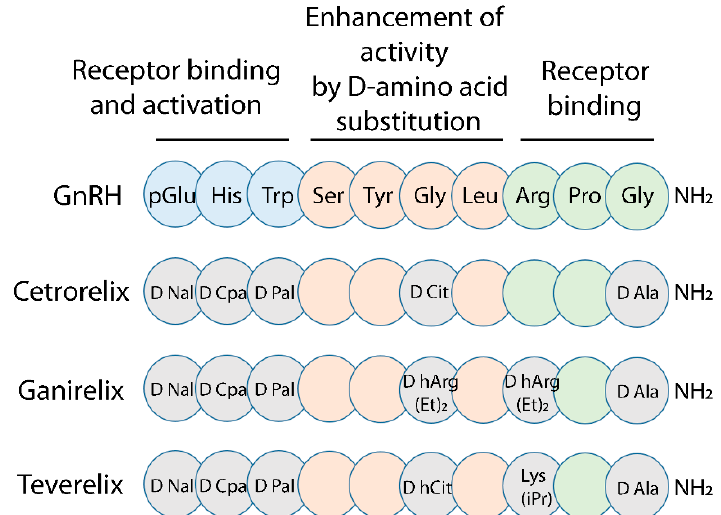
Figure 1. Amino acid sequence of mammalian gonadotropin releasing hormone (GnRH) and antagonists. Substitution of amino acids at position 6 (orange) by D-amino acids increases binding affinity and decreases metabolic clearance, resulting in increased activity of the compound. The COOH-terminal domain (Arg-Pro-Gly-NH 2 group; green) is involved in receptor binding, while the NH 2 -terminal domain (pGlu-His-Trp; blue) is involved in both the receptor binding and activation. Amino acid substitutions falling within the C-terminal region produce antagonists and are indicated by the multiple letter code. The image is adapted from Millar et al. [5].